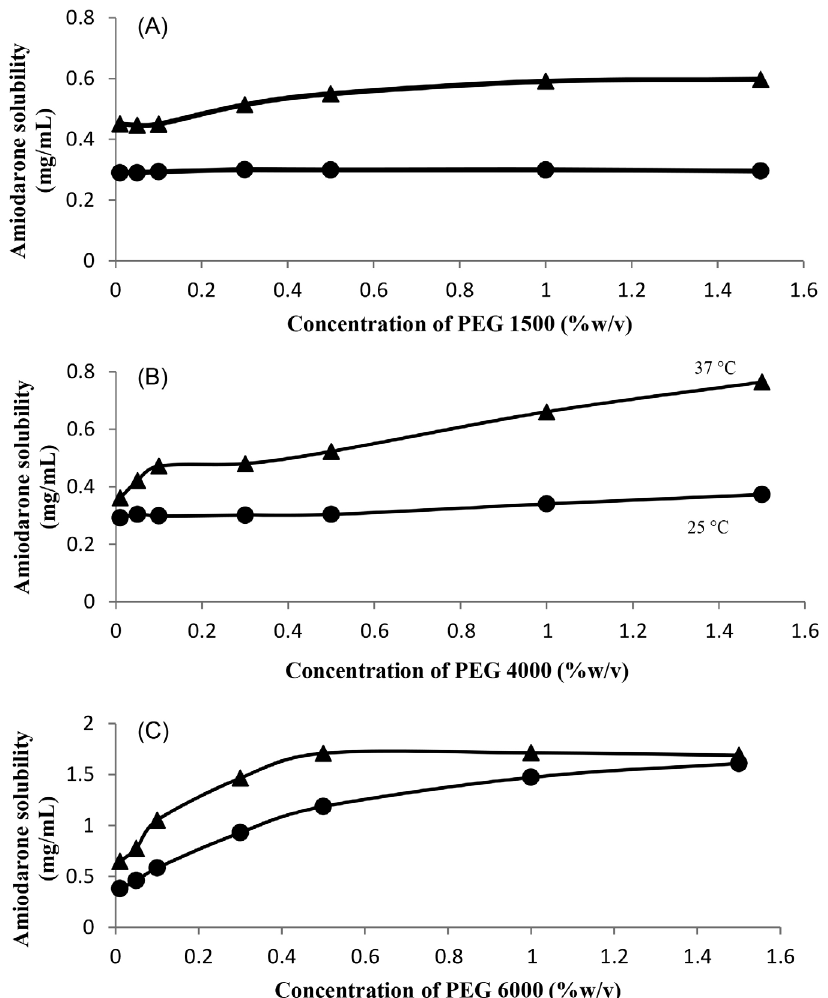
FIGURE 1 - Phase solubility curves of AMH in aqueous solutions of (A) PEG 1500, (B) PEG 4000 and (C) PEG 6000 at 25 and 37 ºC ± 0.5 ºC (n =